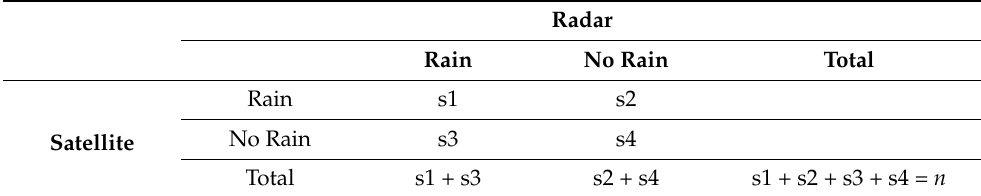
Table 10. Contingency table.